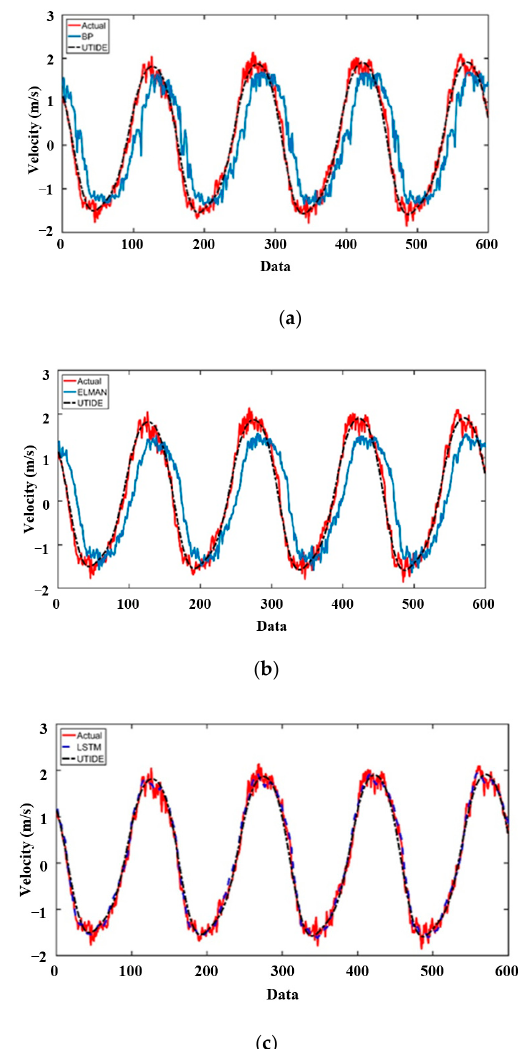
Figure 8. Comparison results of the single input prediction method by using three machine learning algorithms and UTide (20 m under sea surface). ( a ) Comparison of the back-propagation (BP) method, UTide method, and actual value, ( b ) Comparison of the ELMAN method, UTide method, and actual value, ( c ) Comparison of the LSTM method, UTide method, and actual